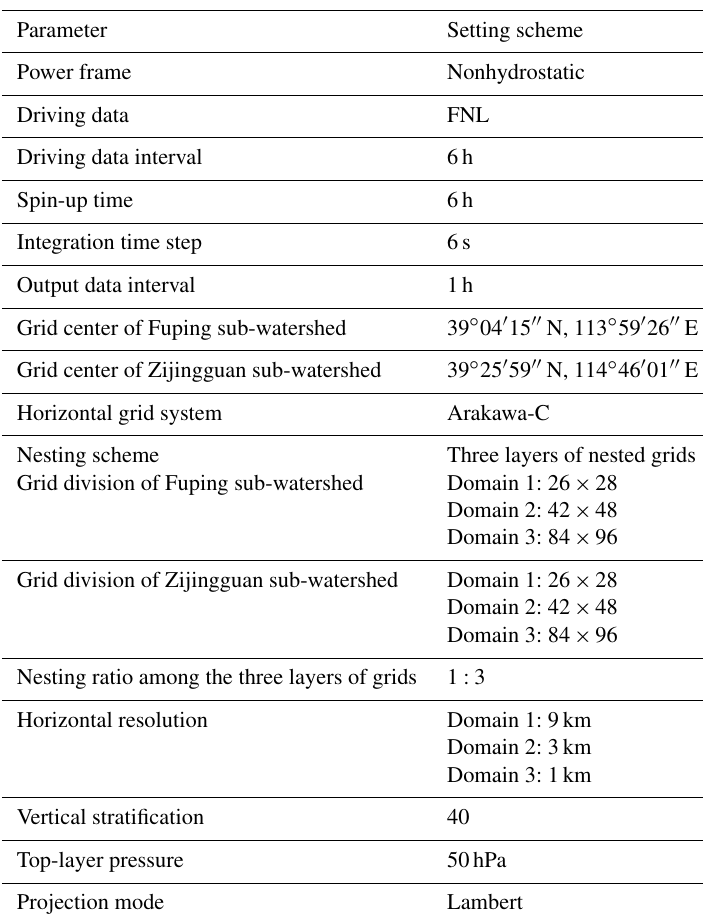
Table 4. Basic settings of the WRF model for the two